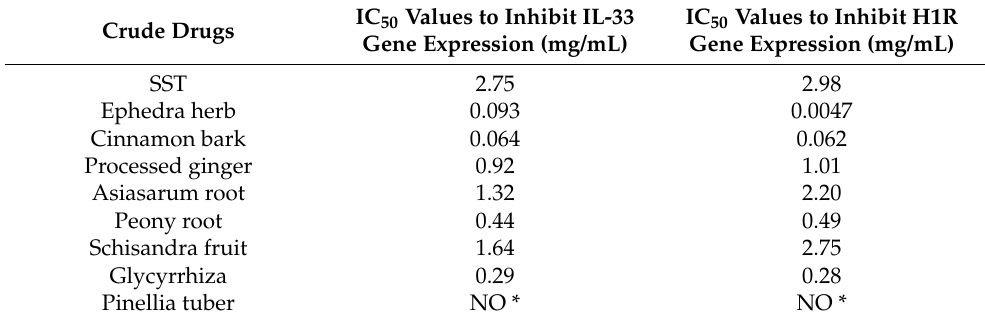
Figure 3. Effects of eight crude drugs of SST on PMA-induced up-regulation of H1R mRNA. HeLa cells were serum-starved for 24 h and treated with Ephedra herb ( A ), cinnamon bark ( B ), processed ginger ( C ), Asiasarum root ( D ), peony root ( E ), Schisandra fruit ( F ), Glycyrrhiza ( G ), and Pinellia tuber ( H ) for 12 h before stimulation with 100 nM PMA. After stimulation with PMA for 3 h, the cells were harvested, and total RNA was prepared. H1R mRNA levels were determined using quantitative RT-PCR. Data are expressed as means ± SEM ( n = 3–4). ## p < 0.01 vs. control; * p < 0.05, ** p < 0.01 vs. PMA. Table 1. Comparison of IC 50 values of SST and its crude drugs to inhibit the IL-33 gene up-regulation with those related to H1R gene